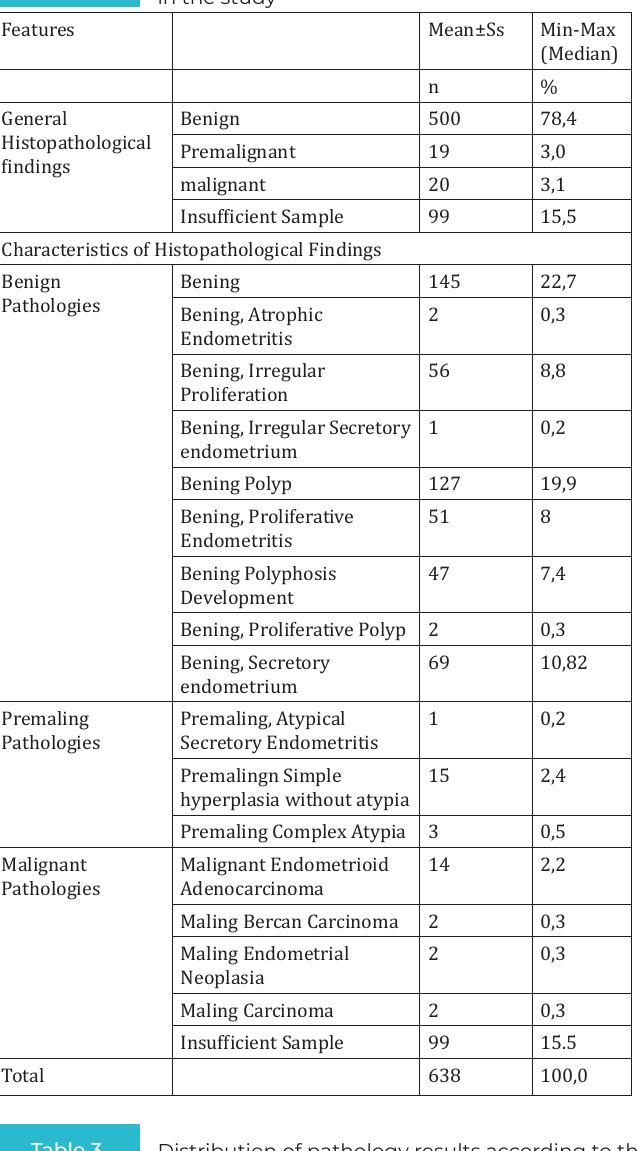
Histopathological findings of the data included in the study